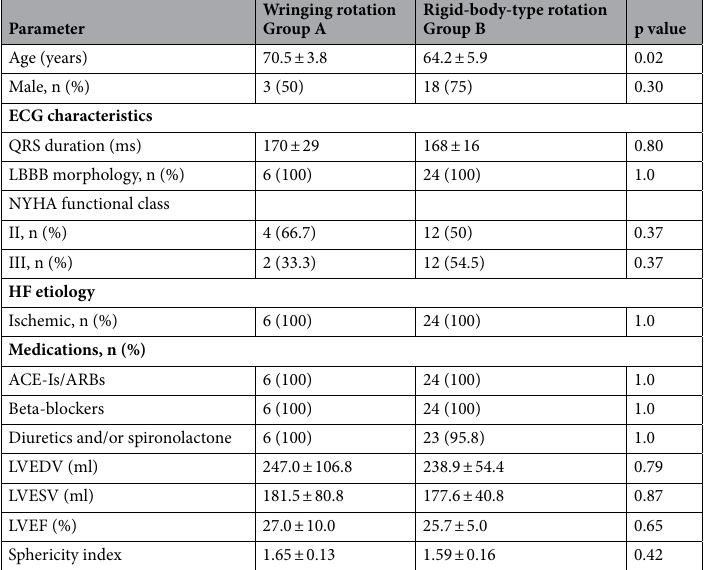
Table 1. Baseline patient characteristics. Values are mean ± SD, median (25th; 75th percentile) or n (%). ACE-I angiotensin-converting-enzyme inhibitor, ARB angiotensin II receptor blocker, LVEDV left ventricle end- diastolic volume, LVESV left ventricle end-systolic volume, LVEF left ventricle ejection